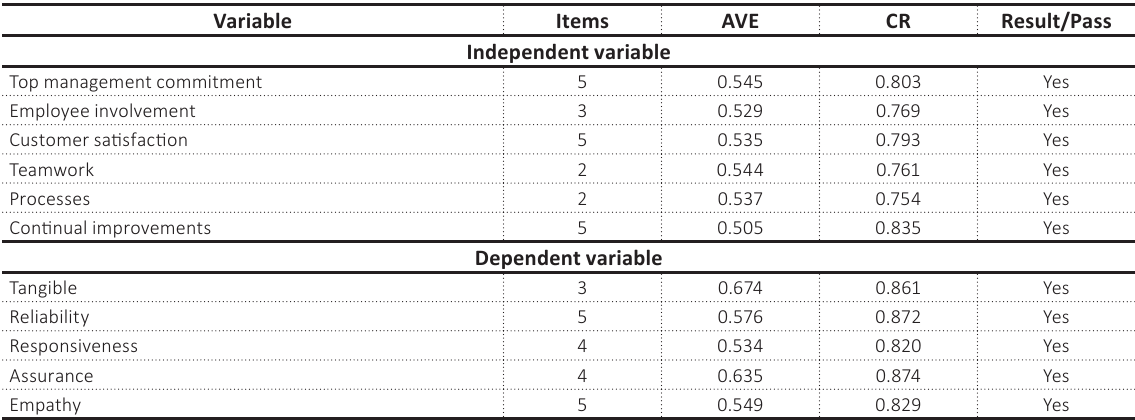
Table 4. Validity